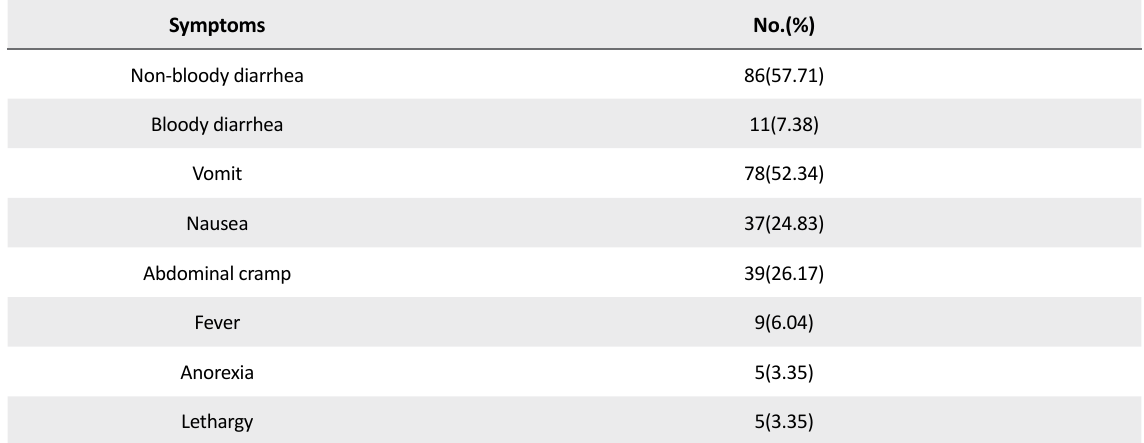
Table 4. Distribution of disease cases by clinical signs and symptoms